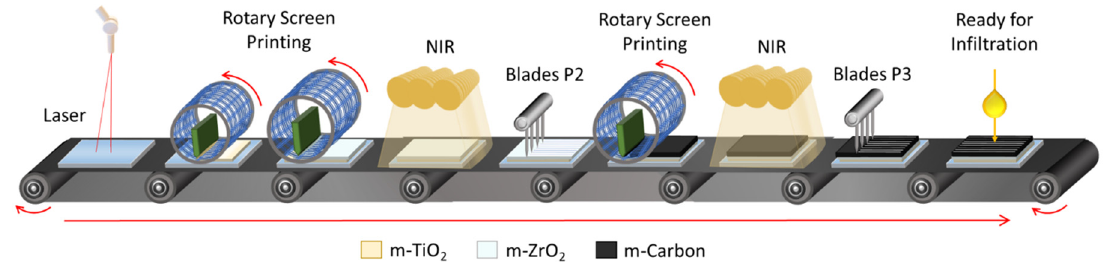
Figure 3. Schematic representation of a possible mCPSC production line using screen-printing, scribing method and NIR fast annealing.